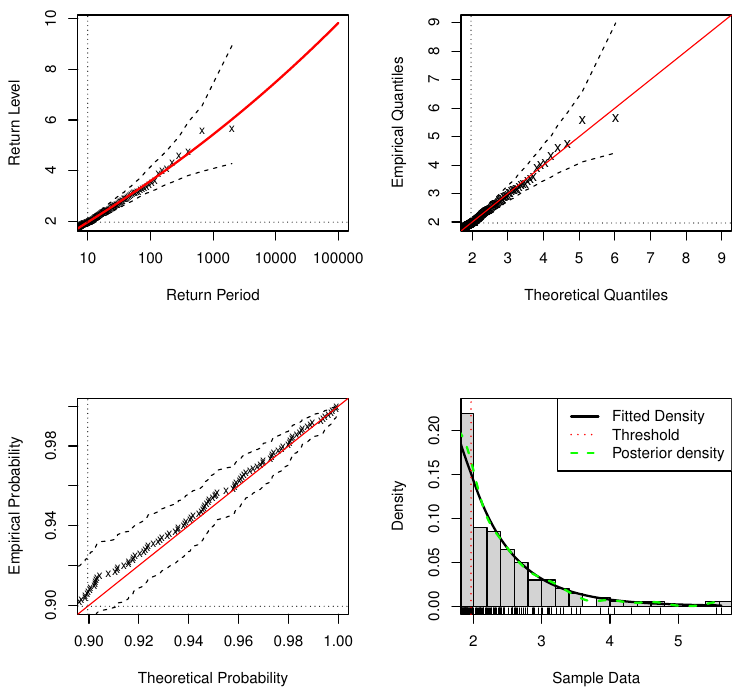
Figure 3. Standard model fit diagnostics for the upper tail of DPMW-PPR model fitted to the simulated data with n = 1000. (The top left corner is the return level plot, the top right corner is the quantile plot, the bottom left corner is the probability plot, and the bottom right corner is the density plot).